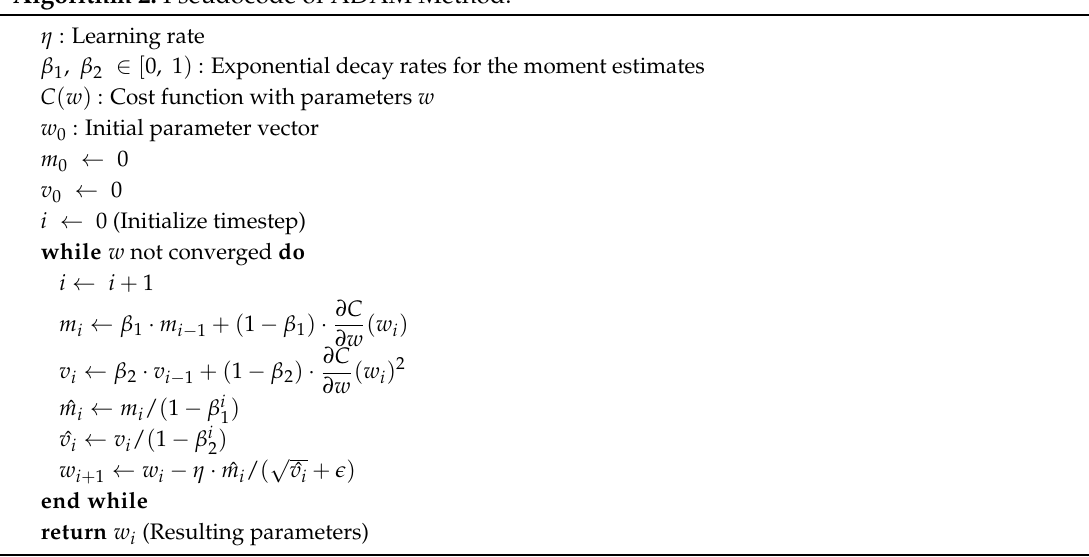
Algorithm 2: Pseudocode of ADAM